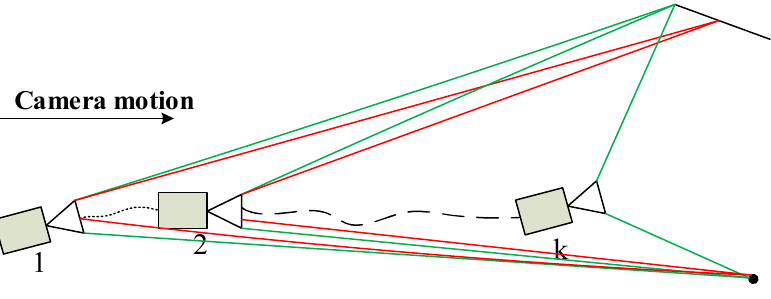
Figure 6. Basic observation and semantic observation of features.